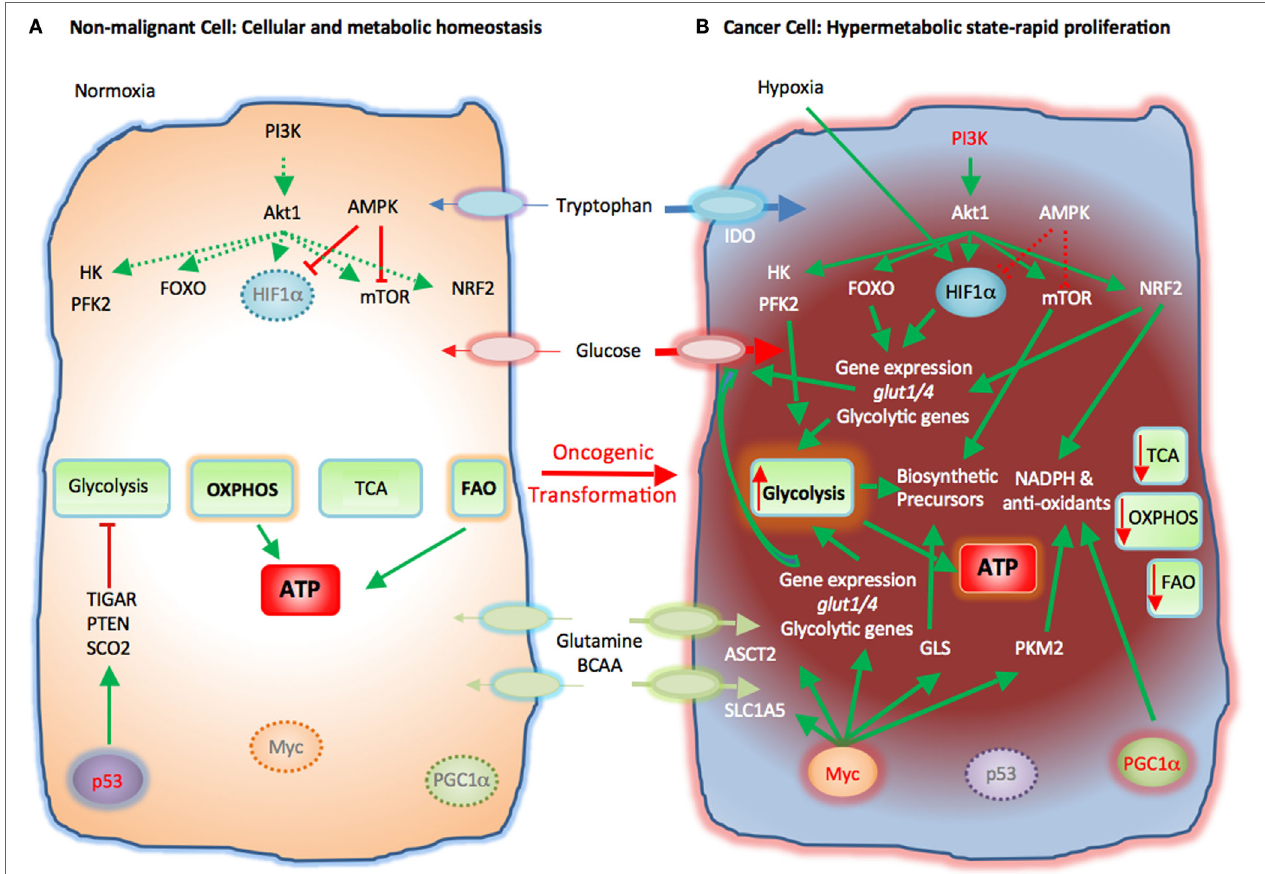
FiGURe 2 | Metabolic reprogramming of cancer cells in the tumor microenvironment (TME). Metabolic switches driven by genetic alterations, alter the cell intrinsic properties of cancer cells leading to metabolic changes in the TME. (A) Nonmalignant cells have low level steady-state biosynthetic activity and low energy demands. Under normoxia, nonmalignant (quiescent) cells rely on oxidative phosphorylation (OXPHOS) as primary ATP source. Steady-state FAO also contributes to the cellular ATP pool. Without extrinsic stimuli the PI3K–Akt pathway is inactive and downstream targets, e.g., HK, PFK2, FOXO, HIF1 α , mTOR, and NRF2, are not activated. Low levels of AMPK activity keep HIF1 α and mTOR in check. p53 participates in the repression of glycolysis by expression of TIGAR, PTEN, and SCO2. Myc and PGC1 α are not active in quiescent cells. (B) Cancer cells acquire mutations that promote glycolysis by multiple mechanisms. Oncogenic PI3K–Akt signaling and suppressed AMPK signaling induce activation of glycolytic enzymes such as HK and PFK2 and transcription factors such as FOXO. Hypoxia-induced HIF1 α also promotes the expression of glucose transporters glucose transporter 1 (Glut1) and Glut4 and glycolytic enzymes. mTOR signaling is enhanced causing an increase in biosynthetic precursors. Activated PI3K–Akt signaling leads to upregulation of NRF2 and expression of glycolytic genes, NADPH, and anti-oxidants thereby protecting cancer cells from oxidative damage. PGC1 α contributes to the intracellular anti-oxidant defense mechanisms. Mutation or deletion of p53 results in loss of glycolytic inhibitors, such as TIGAR, PTEN, and SCO2, whereas oncogenic Myc induces expression of glucose transporters and glycolytic genes resulting in dominance of glycolysis as the key metabolic pathway in cancer cells. Oncogenic Myc also promotes the expression of glutamine transporters and GLS. Myc also enhances the levels of cellular NAPDH and anti-oxidants via PKM2. Expression of IDO induces degradation of tryptophan to N -formylkynurenin. These molecular changes induce a dramatic augmentation of nucleotide, amino acid, and lipid biosynthesis, which are paired with enhanced catabolic pathways to enable cancer cells to proliferate rapidly. Abbreviations: Akt1, protein kinase B; AMPK, AMP-activated protein kinase; ASCT2, alanine, serine, and cysteine system amino acids transporter 2; ATP, adenosine triphosphate; BCAA, branched-chain amino acids; FAO, fatty acid oxidation; FOXO, forkhead-Box O; Glut1/4, glucose transporter1/4;